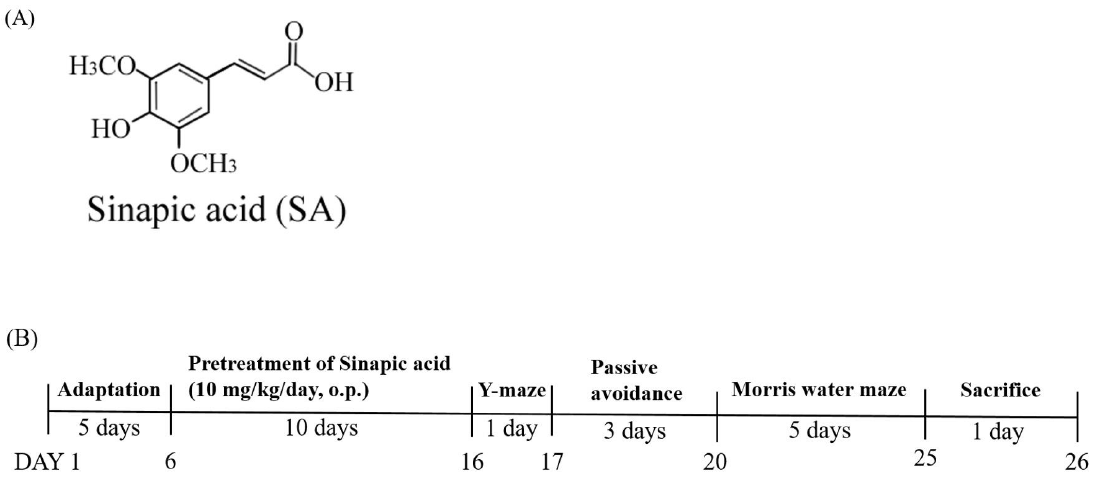
Figure 1. Experimental design. ( A ) Two-dimensional chemical structure of sinapic acid (SA). ( B ) Time schedule of the behavioral test. Long-term potentiation (LTP) is defined as the ability to convert electrical stimuli into chemical signals, thereby activating the pre-synaptic and post-synaptic mechanisms, resulting in a continuous increase in synapses [23]. LTP is induced by the activation of N- methyl-D-aspartate (NMDA) type glutamate receptors via the simultaneous activity of the pre- and post-synaptic neurons [24]. LTP has been proposed as a synaptic mechanism of cognitive function because NMDA receptor-dependent LTP can constitute the cellular substrate of learning and memory [25,26]. In this study, the neuroprotective and anti-inflammatory effects of SA in SCOP- induced learning and memory impairment models were evaluated through electrophysiological, behavioral, and immunological experiments. 2. Materials and Methods 2.1. Materials Sinapic acid (SA, D7927), scopolamine hydrobromide (SCOP, S0929), 4-(2- hydroxyethyl)-1-piperazineethanesulfonic acid (HEPES, H4034), L-glutamine (G-8540), D-glucose (G7021), sodium chloride (NaCl, S7653), potassium chloride (KCl, P5405), calcium chloride dihydrate (CaCl2, C7902), magnesium chloride hexahydrate (MgCl2, M2393), sodium carbonate (NaHCO3, S5761) and penicillin-streptomycin (P4333) were purchased from Sigma-Aldrich (St. Louis, MO, USA). Sodium dihydrogen phosphate (NaH2PO4, AB15ES) was obtained from DAEJUNG (Siheung, Republic of Korea). Minimum essential medium (MEM, LM 007- 01) and Hank’s balanced salt solution (HBSS, LB 003-01) were purchased from Welgene (Kyungsan, Republic of Korea). Donor horse serum (HS, S0910-500) was obtained from Biowest (Nuaillé, France). All of the reagents used in the experiments were research grade products. 2.2. Experimental Animals Seven day old Sprague-Dawley (SD) rats were used in an organotypic hippocampal slice culture (OHSCs), and 5 week old male SD rats (weighing 140 ± 10 g) were used in the behavioral test. The rats used in the experiment were purchased from Saerone Bio, Inc (Uiwang, Republic of Korea). A standard diet for feeding during the entire experimental period was provided by Saeron Bio Inc. The indoor conditions were maintained at 12 hr